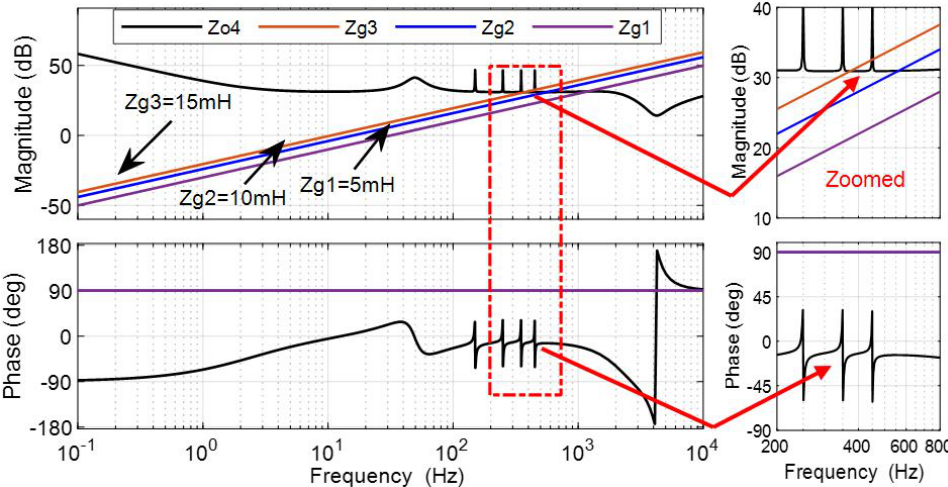
Figure 12. Impedance-based stability of grid tied inverter with proposed hybrid